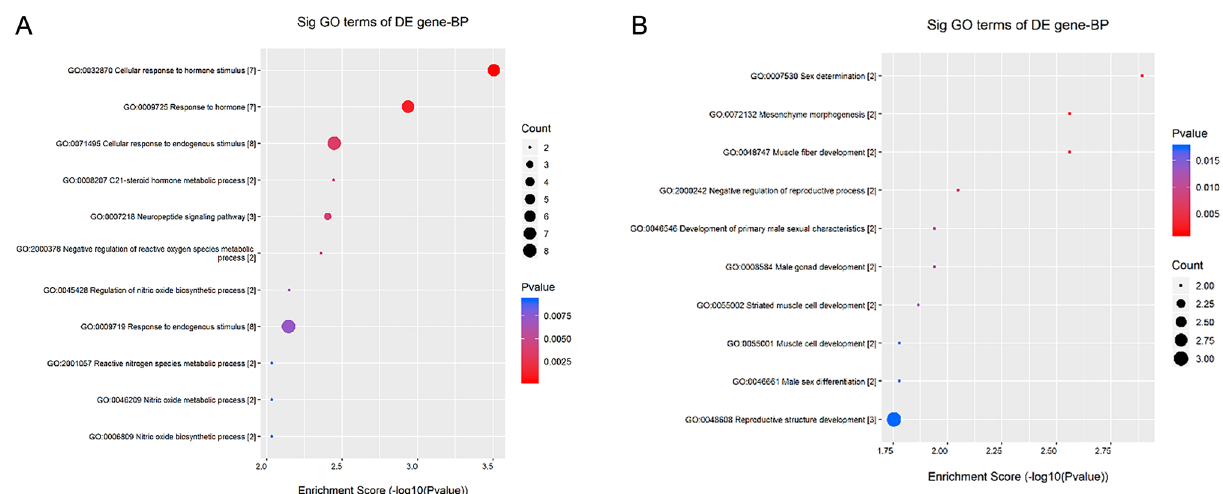
Figure 3. The biological processes enrichment analyses for the differentially expressed genes (DEGs) analysed by Gene Ontology (GO). ( A ) The top ten biological processes with upregulated Enrichment Score Dot Plot. ( B ) The top ten biological processes with down-regulated Enrichment Score Dot